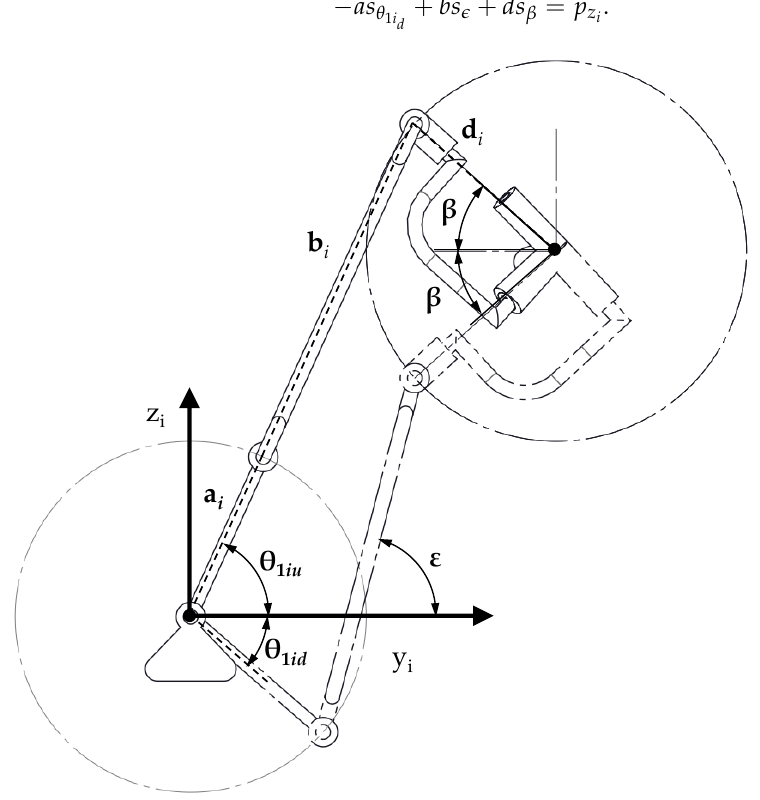
Figure 7. Geometric model for θ 1 i